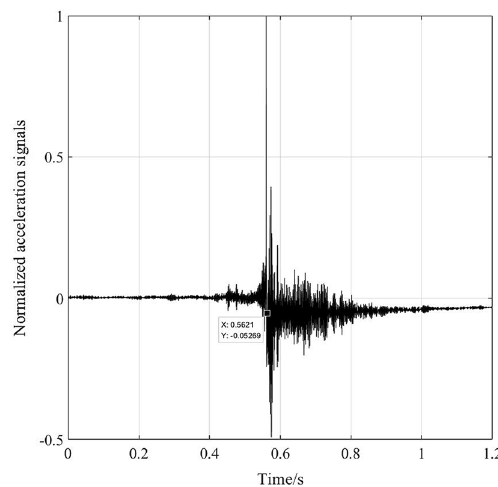
Figure 9. Impact signals.